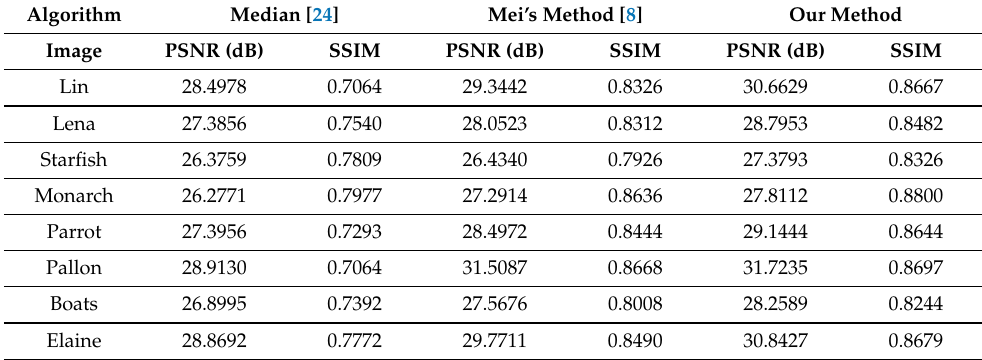
Table 3. PSNR and SSIM values for different algorithms ( η = 0.04).